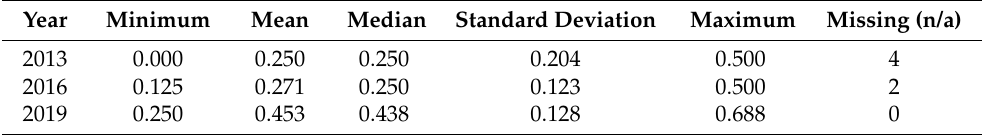
Table 5. The BEB index: descriptive